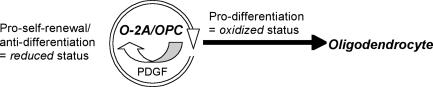
Diagrammatic Summary of the Role of Redox Regulation in Modulating Division and Differentiation of O-2A/OPCsProgenitor cells are induced to divide by exposure to PDGF. Induced to divide by PDGF alone, progenitors will undergo a limited number of divisions while asymmetrically generating oligodendrocytes. The balance between division and differentiation is modulated, however, by the intracellular redox state [59]. Cells that are more oxidized tend to differentiate, whereas those that are more reduced undergo more self-renewal. Pharmacological agents that make cells more oxidized induce differentiation of dividing O-2A/OPCs into oligodendrocytes. Similarly, signaling molecules that induce differentiation (e.g, TH) make cells more oxidized as a necessary part of their mechanism of action. In contrast, pharmacological agents that make cells more reduced promote self-renewal, and signaling molecules that enhance self-renewal (e.g, NT-3) make cells more reduced as a necessary part of their mechanism of action.